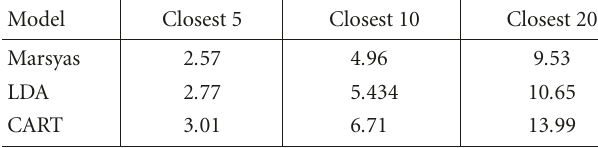
Table 4: Average number of closest songs with the same genre.